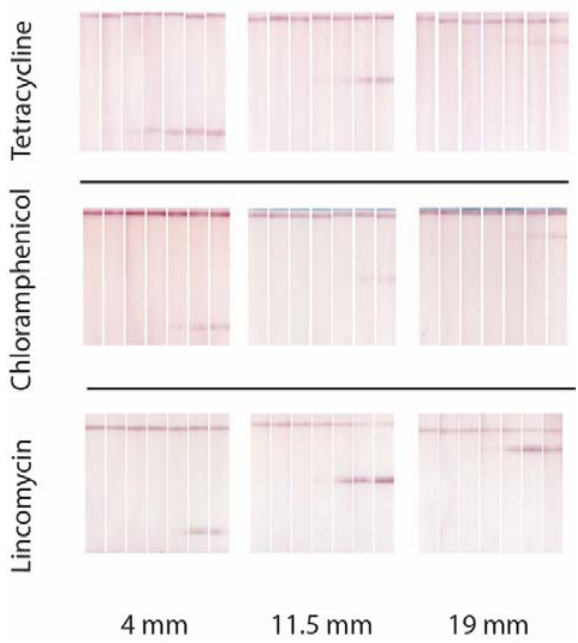
Figure 1. Test strip images after analysis of antibiotics ‐ contained serum samples for different location of test zones. Test strips are arranged from left to right in accordance with the antibiotics concentration (100, 33, 11, 3.7, 1.2, 0.4 and 0 ng/mL).